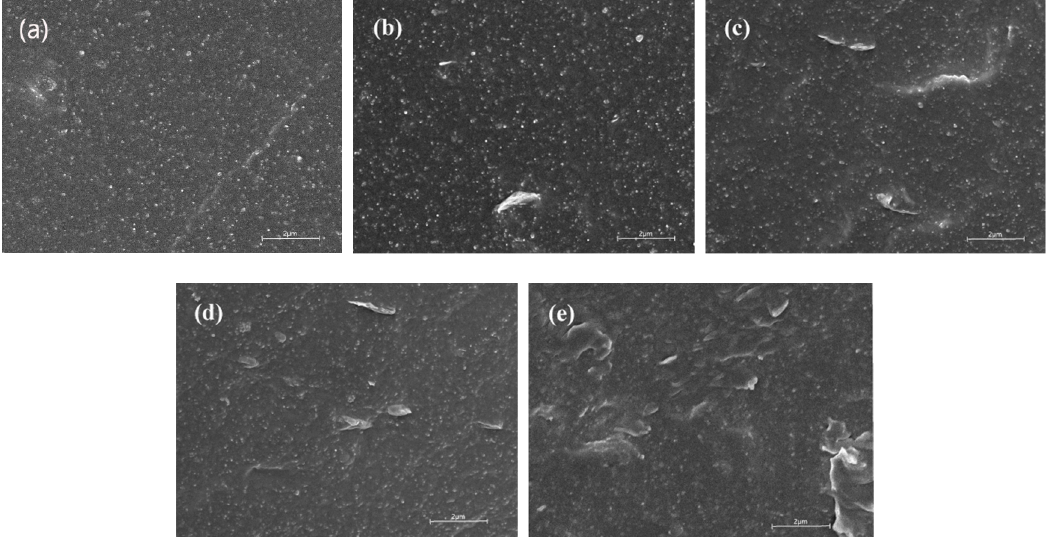
Figure 8. SEM images of rubber sections with various OMMT contents: ( a ) 0 phr, ( b ) 2 phr, ( c ) 4 phr, ( d ) 6 phr, and ( e ) 8 phr.